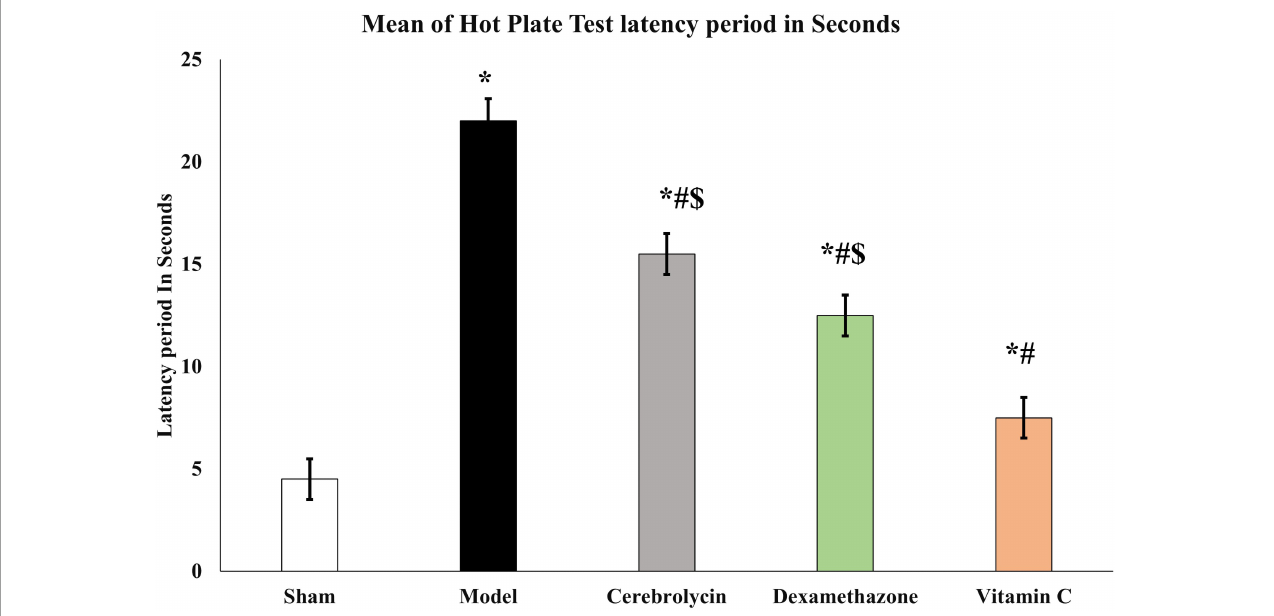
FIGURE3 Hot plate test histogram representing the withdrawal latency period of a hot plate test. *Significance as compared to control, # significance as compared to the model, and $ significance as compared to Vit C